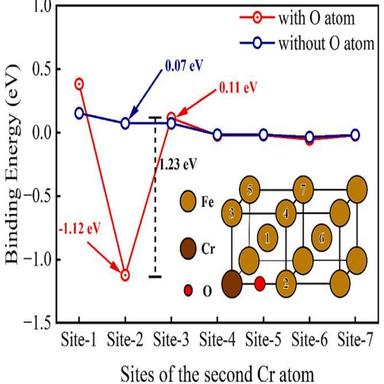
The binding energy between two substitutional Cr atoms in BCC-Fe in the presence/absence of one O.